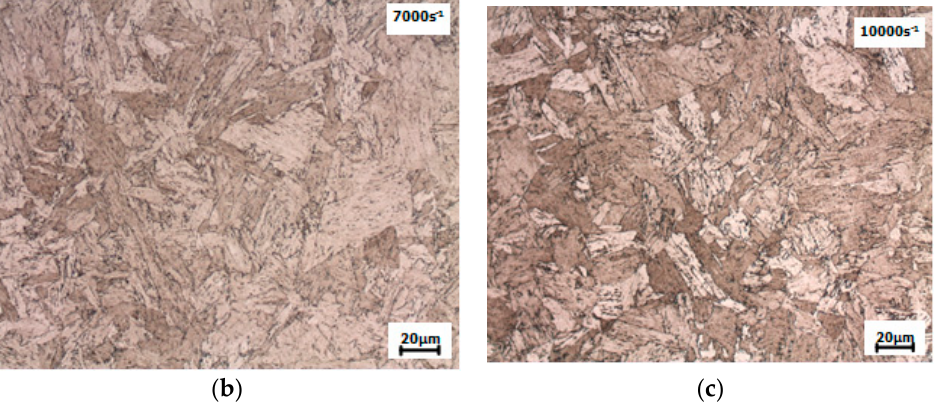
Figure 5. True stress–strain curves ( a ) and its corresponding optical photomicrographs of SHPB tested samples deformed at 300 °C and strain rate ( b ) 7000 s − 1 ; and ( c ) 10,000 s − 1 .